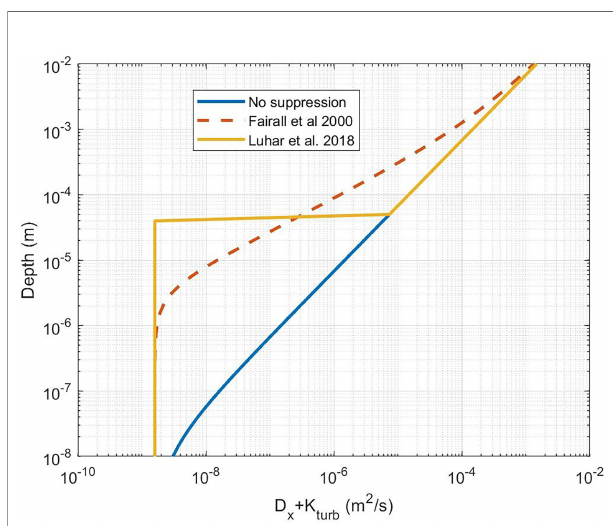
FIGURE 3 | Near-surface pro fi le of the sum of molecular and turbulent diffusivities. The blue line is for K ( z ) without near-surface dissipative suppression (Eq. (18) with d u = 0 ). The dashed line is (41). The yellow line is the Luhar et al. (2018) approximation using